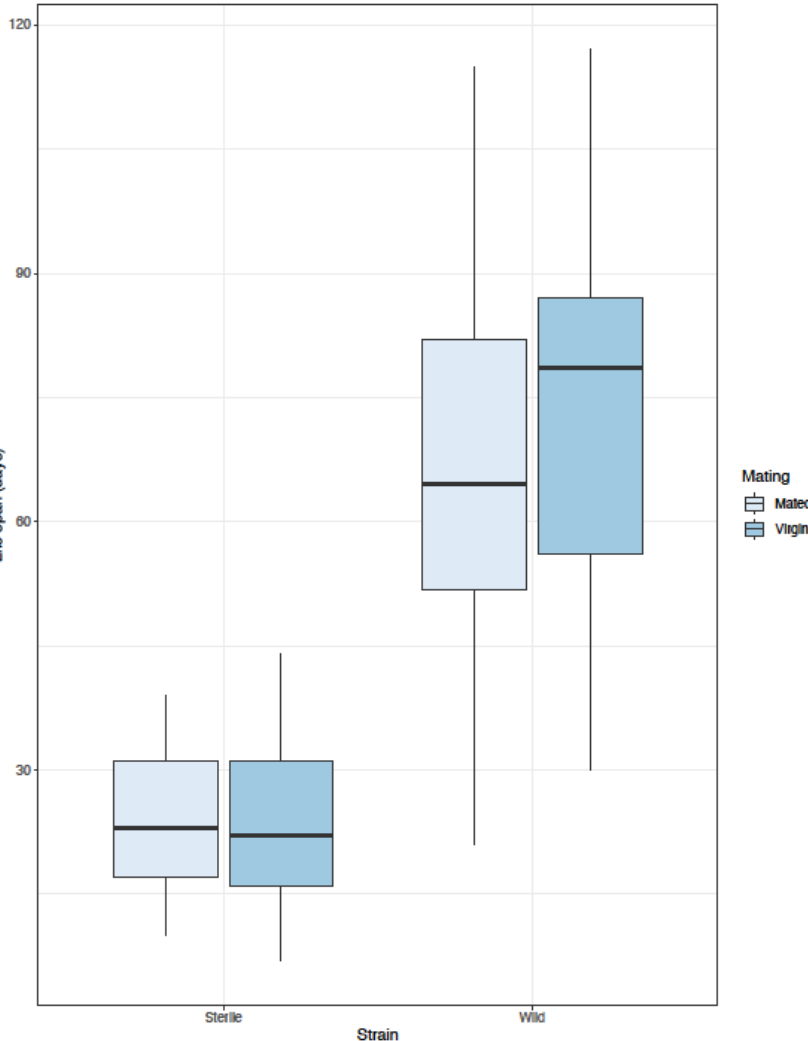
Figure 3. Box plots depicting the effect of male type (wild or sterilized) and mating status (mated or